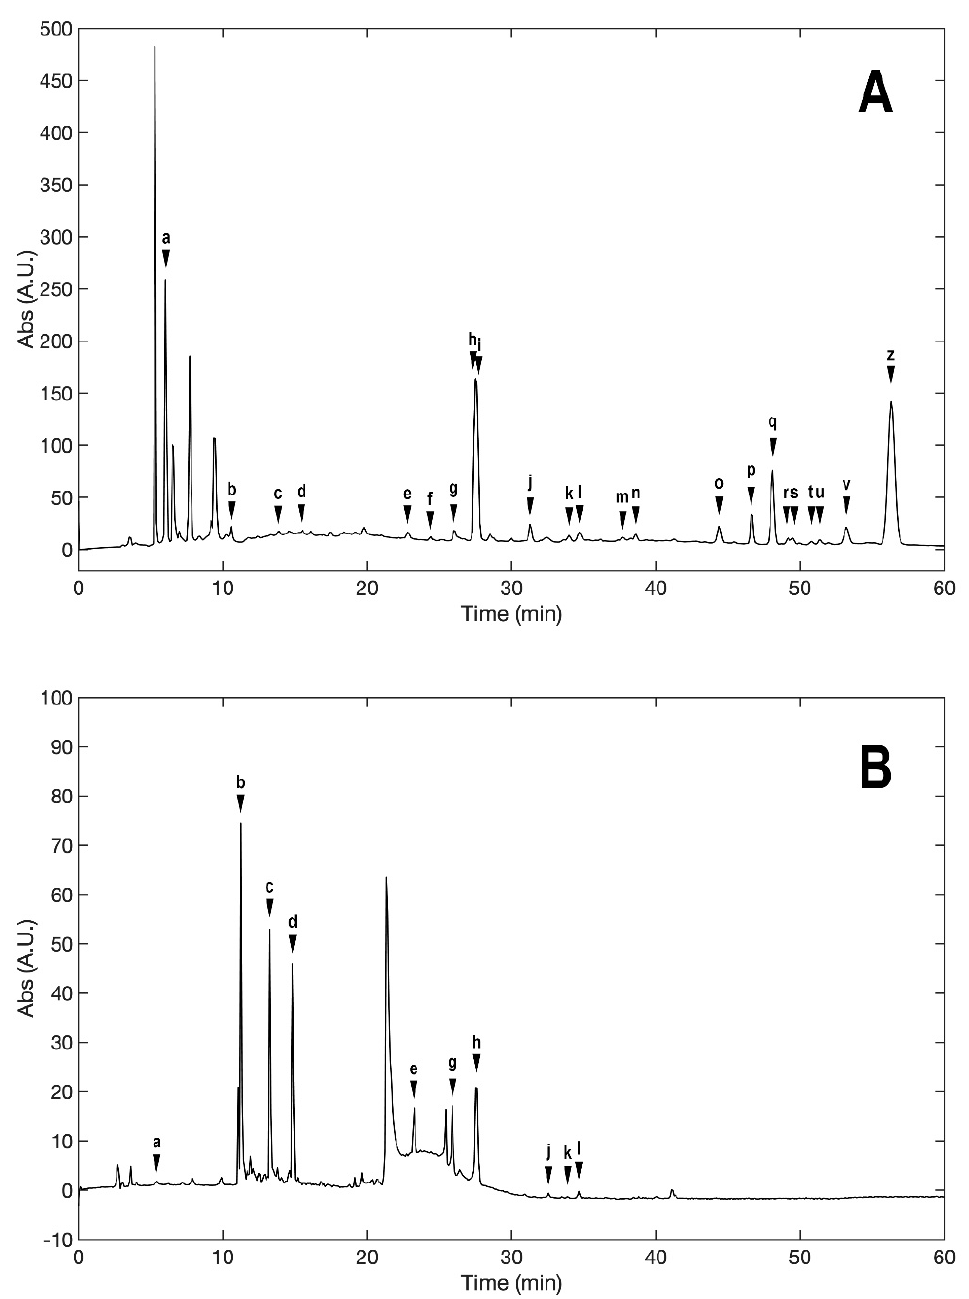
Figure 1. Phytochemical profile of the decoction (AKE (D), Panel ( A )) and maceration (AKE (M), Panel ( B )) extracts obtained upon chromatographic analysis. a, Shikimic acid; b, Gallic acid; c, Loganic acid; d, 5-caffeylquinic acid; e, Swertiamarin; f, Catechin hydrate; g, Delphinidin − 3,5 − diglucoside; h, Amygdalin; i, Sweroside; j, Chlorogenic acid; k, Vanillic acid; l, Caffeic acid; m, Epichatechin; n, Syringic acid; o, p-Coumaric acid; p, Ferulic acid; q, Naringin; r, Rutin hydrate; s, Hyperoside; t, Resveratrol; u, Amarogentin; v, Kaempferol − 3 − glucoside; z, Quercetin dihydrate.